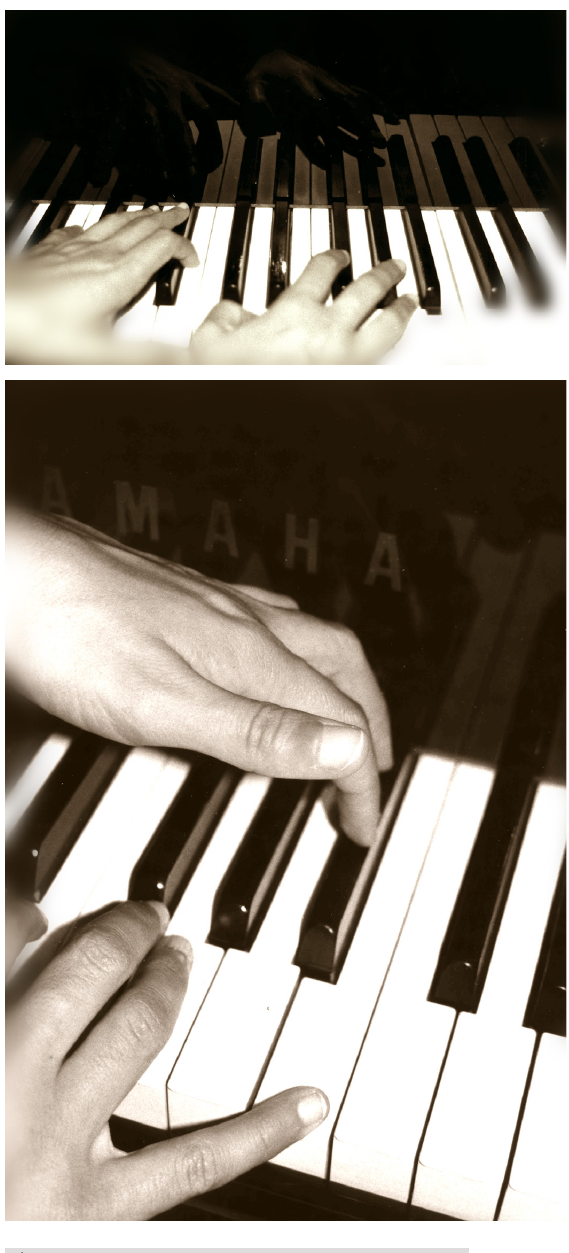
1 | Fig. 1. Sofia trying out the piano music